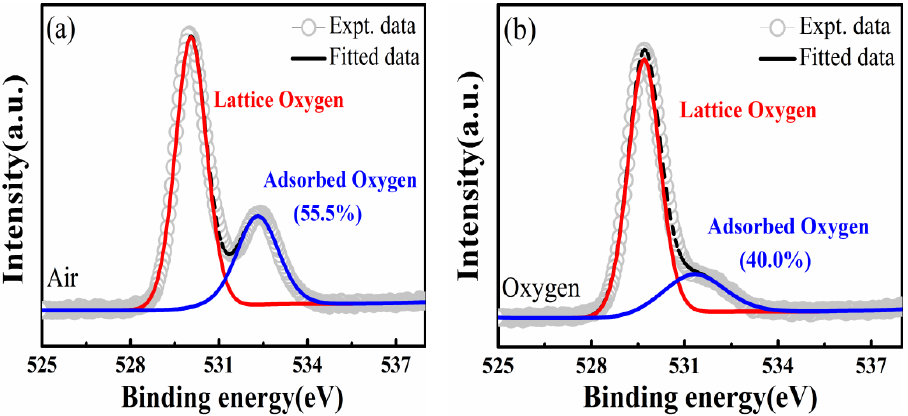
Figure 5. XPS high-resolution spectra of O 1s of the BIT film annealed in ( a ) air and ( b ) oxygen atmospheres.